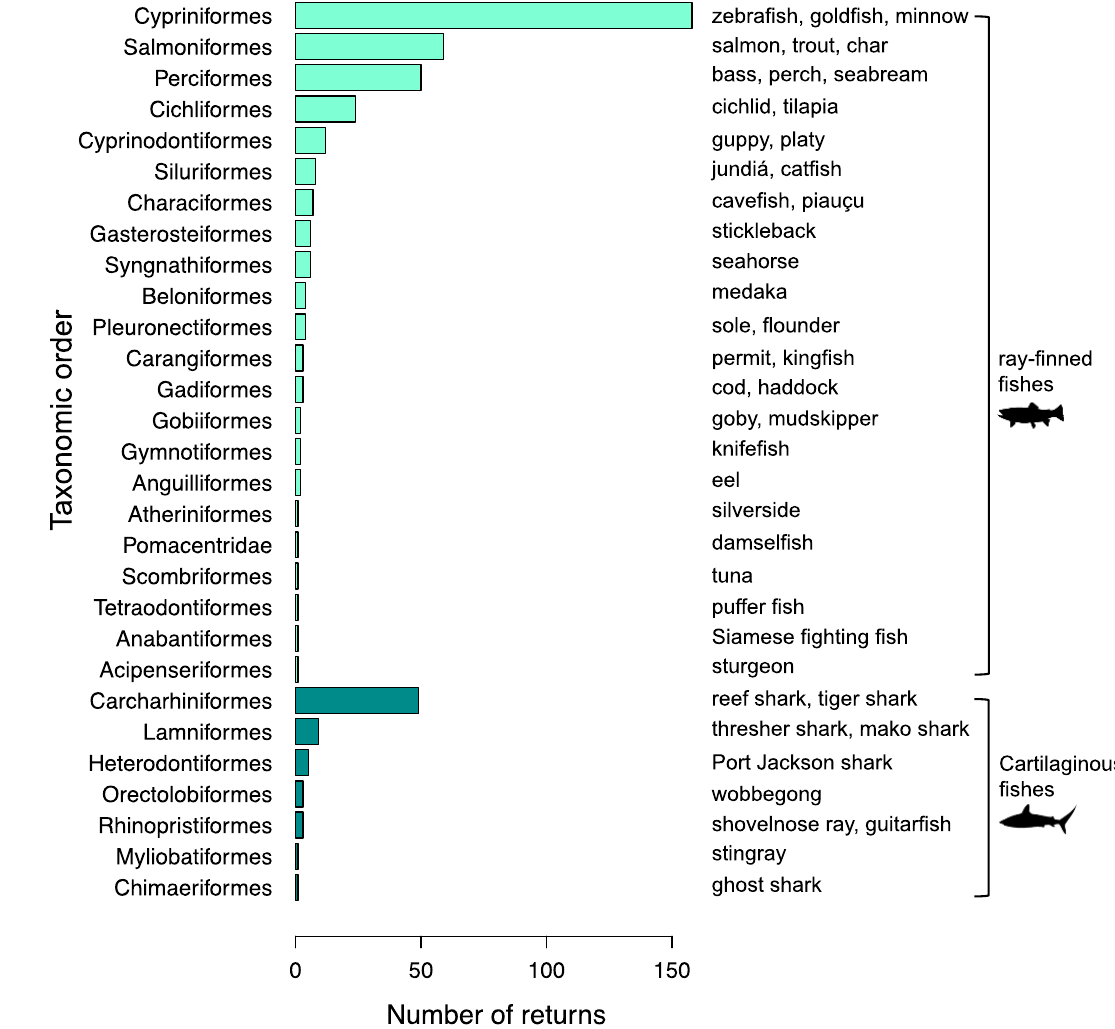
Figure 2. The number of returns from our search of the literature for evidence of sentience in fish. The graph shows the number of times each order featured in studies published between 1990 and 2020 that either assumed or explored sentience in fish, along with the most frequently returned types of fish that featured for each order.